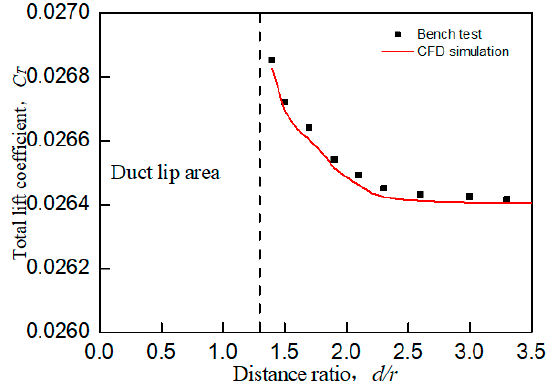
Figure 9. Lift ratio of ground effect by CFD simulations.